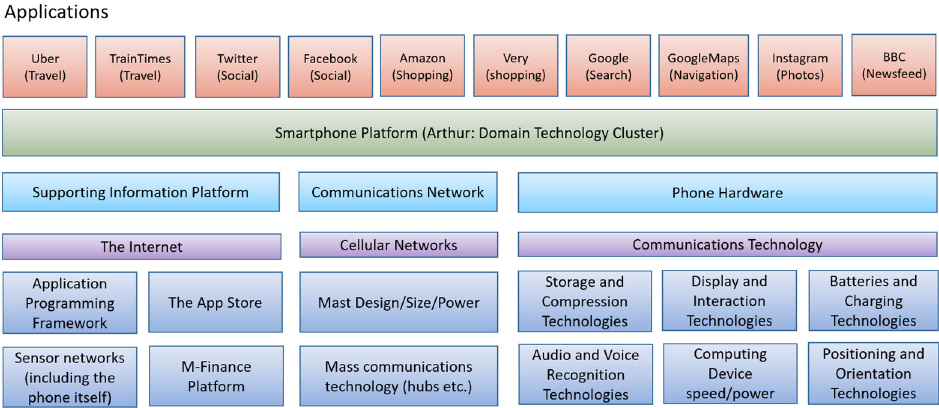
Figure 2. Technologies supporting the smartphone platform.